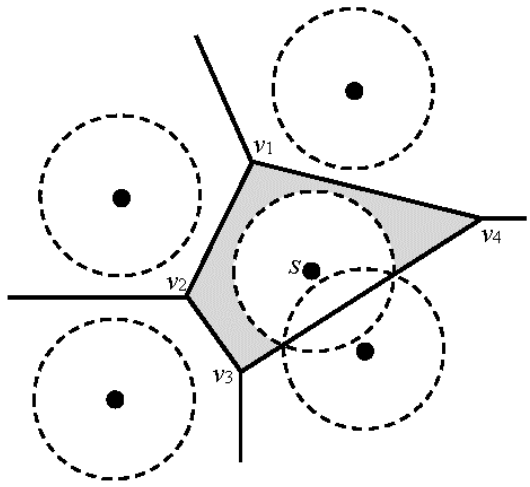
Figure 6. Voronoi diagram for five sensors in a network. Dashed circles represent the sensing area of each sensor; the gray region represents the uncovered area of the Voronoi cell associated to the sensor s .